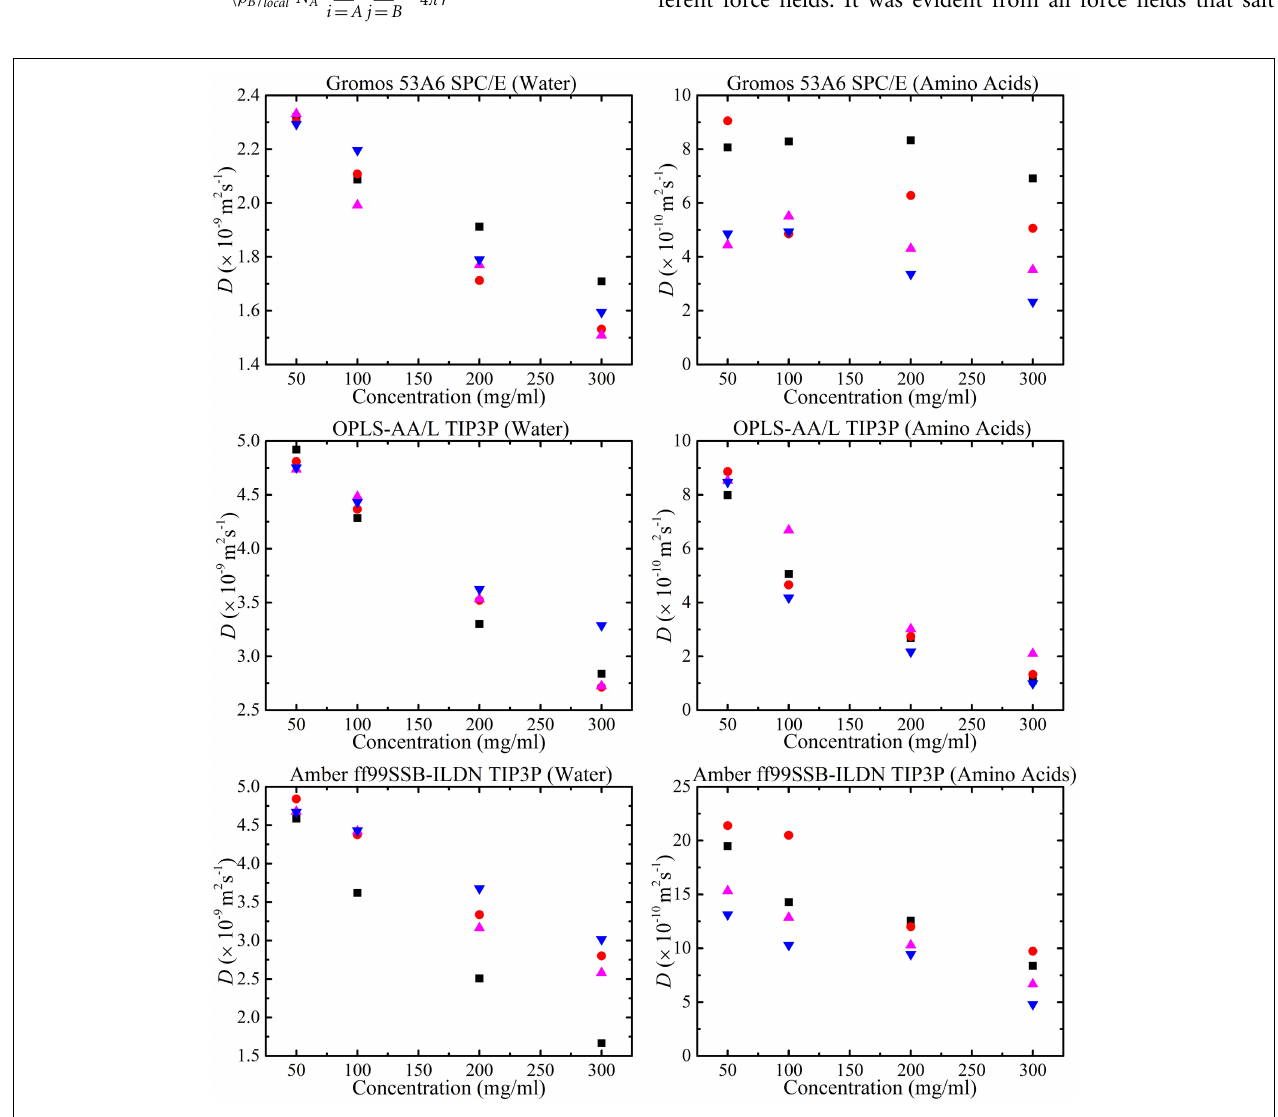
FIGURE 12 | Amino acid concentration dependence of water (left column) and amino acid (right column) diffusion coefficients using GROMOS 53A6 and the SPC/E water model, OPLS-AA/L and the TIP3P